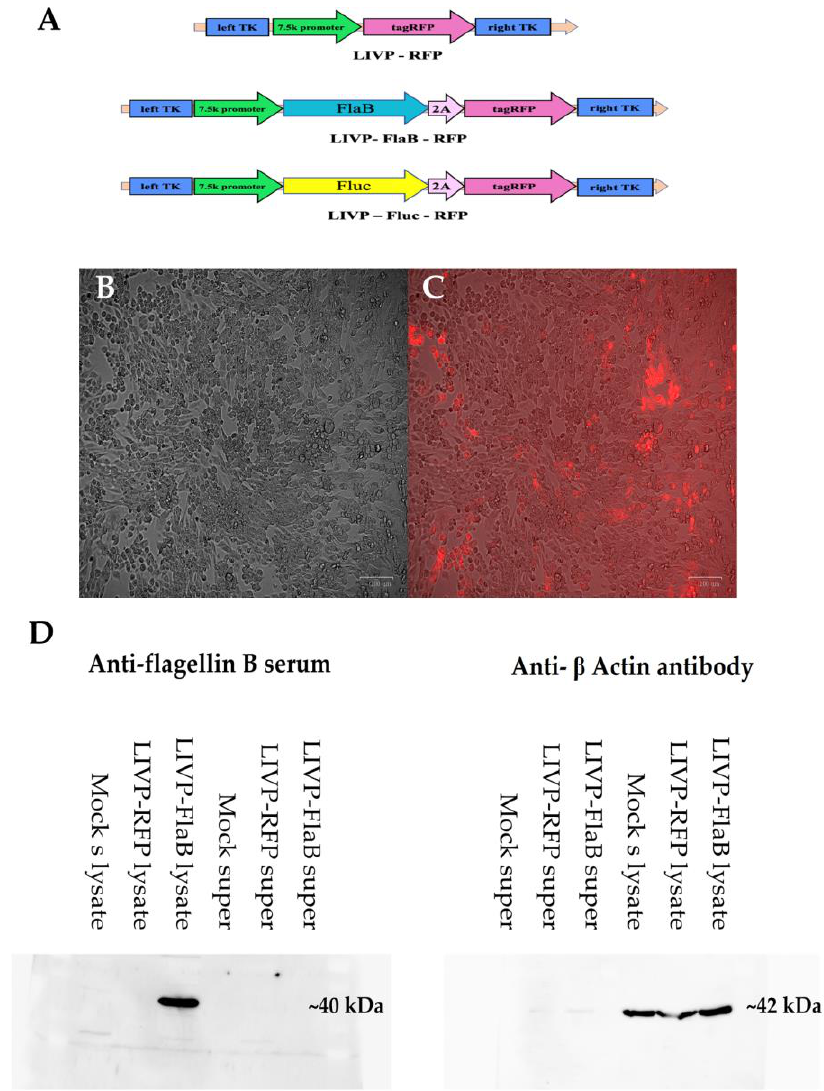
Figure 1. Characteristics of recombinant viruses. Schematic illustration of the plasmid’s constructions ( A ). Microphotographs of BHK-21 cells 24 h after infection with MOI 1 LIVP-FlaB-RFP (20 × magnification, scale bar represents 100 µ m), pictures are taken on a red fluorescent channel ( B ) and bright field microscope ( C ), (microphotographs of BHK-21 cells infected with LIVP-RFP and LIVP-Fluc-FRF are presented in Supplementary Figure S1A,B). ( D ) Western blotting analysis of FlaB (~40 kDa) in cell lysate/supernatant (super) of infected cells by LIVP-FlaB-RFP, LIVP-RFP, and non-infected cells (control); the anti- β -Actin antibody was used as a control. Cell lysate of the infected cells by LIVP-FlaB-RFP is positive for FlaB.